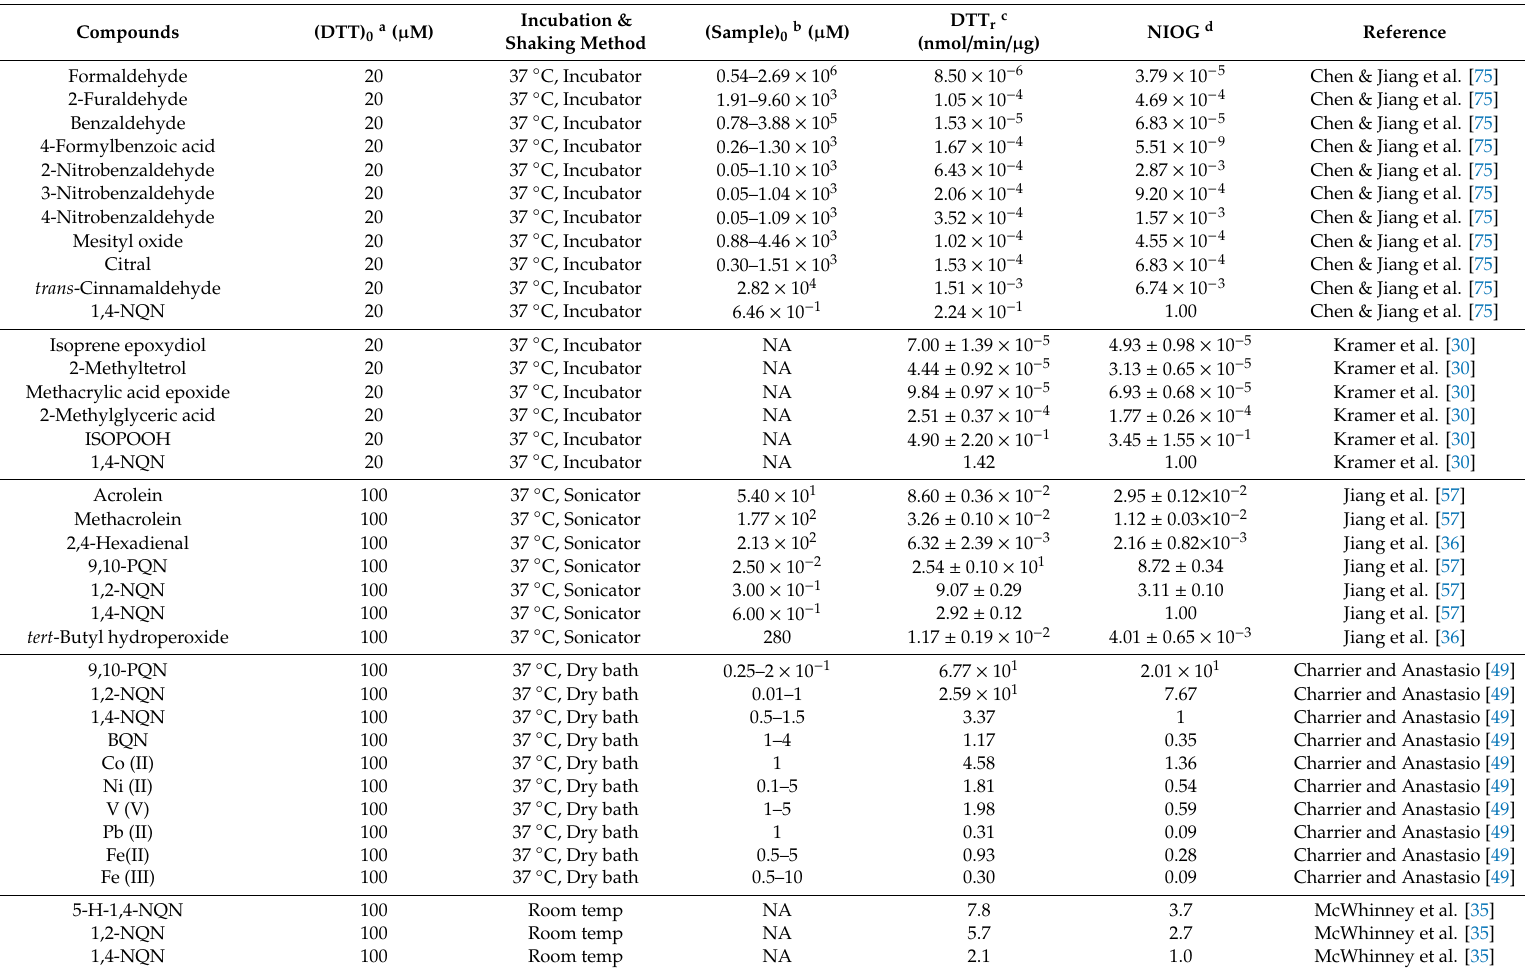
Table 1. The summary of dithiothreitol (DTT) responses of oxidative